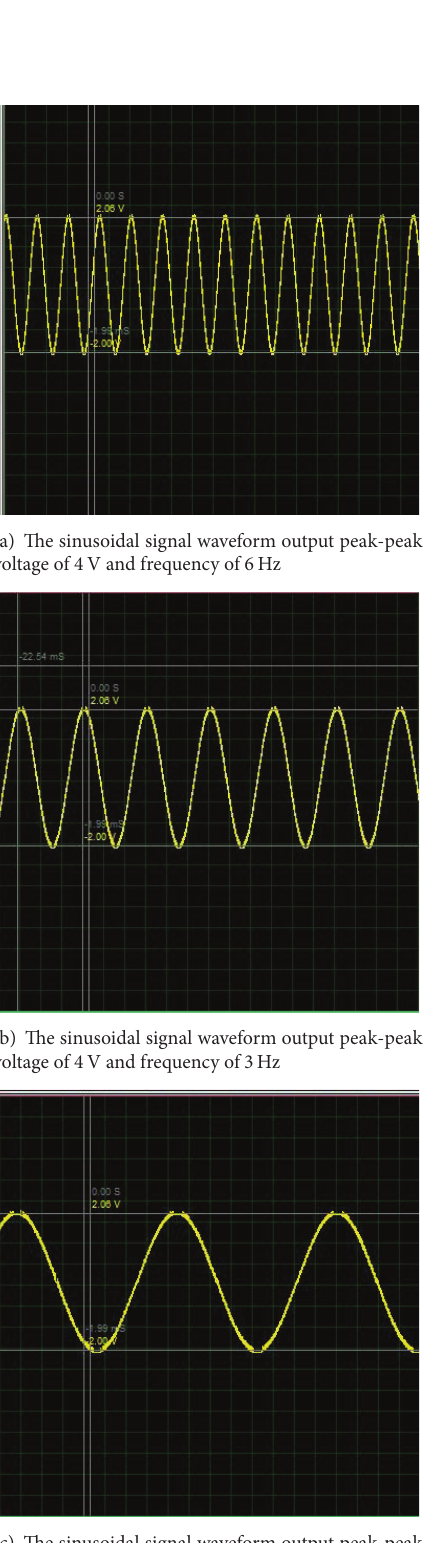
Figure 26: Sinusoidal signal output waveform with different fre- quency and fixed amplitude.